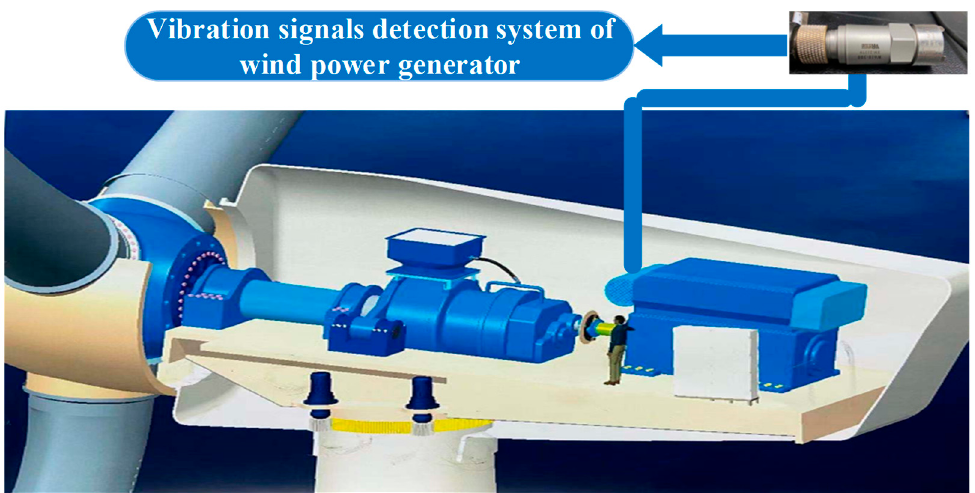
Figure 5. Vibration signals detection system of rolling bearing embedded in wind turbine generator.